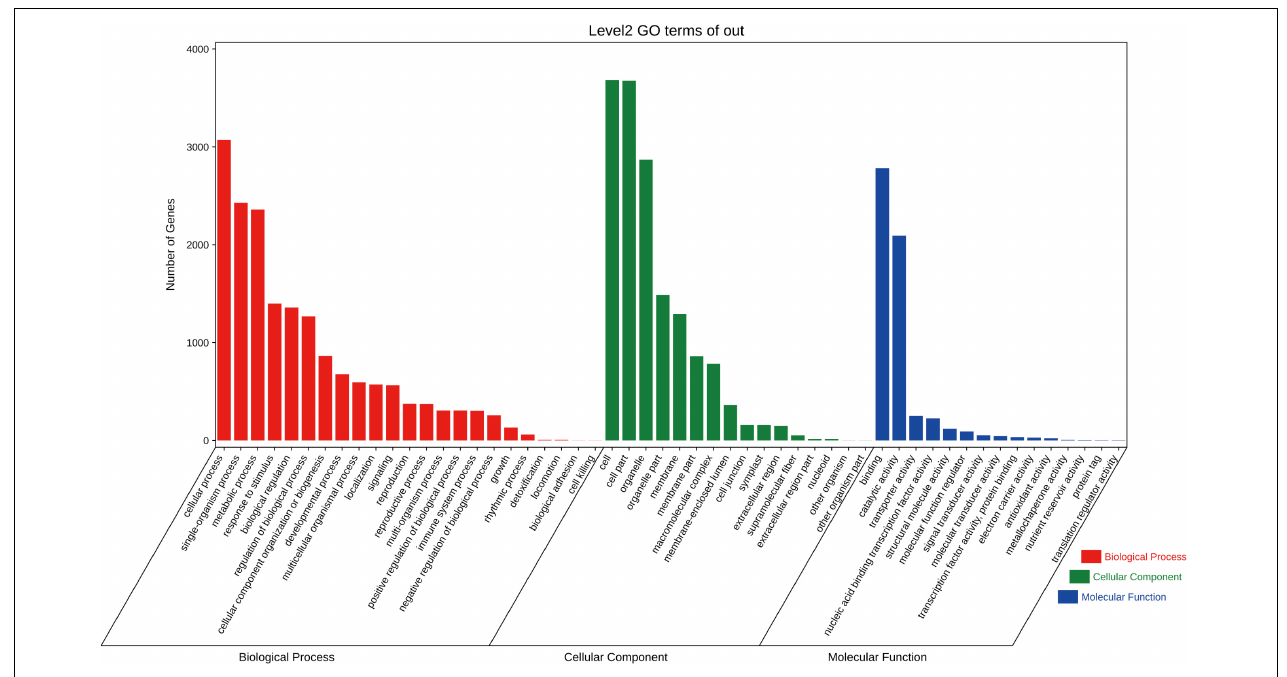
FIGURE 5 | Gene Ontology classification of targets in C. fortunei . The x -axis is the entry name, and the y -axis represents the number of genes in the corresponding entry.